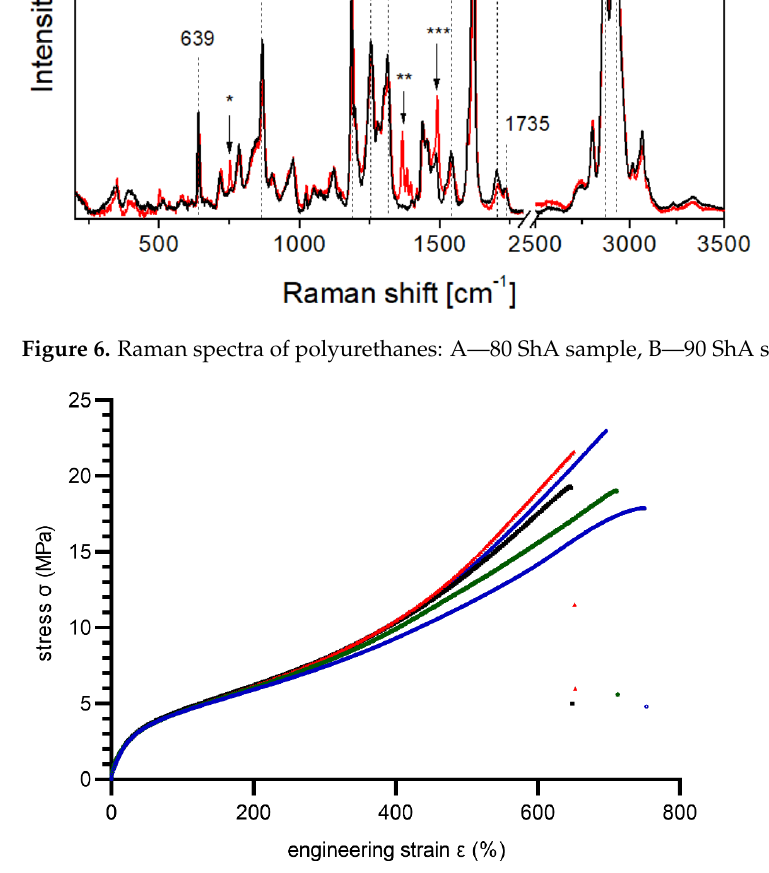
Figure 6. Raman spectra of polyurethanes: A — 80 ShA sample, B — 90 ShA sample.